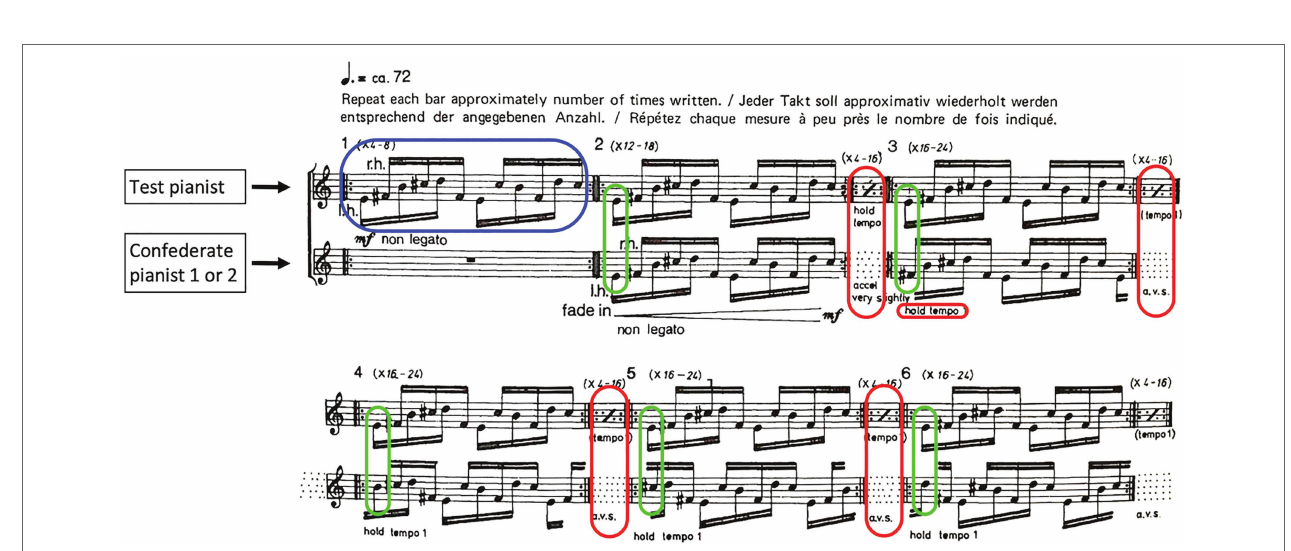
FIGURE 5 | Annotated first 11 bars of Piano Phase (1967) by Steve Reich (blue = melodic pattern, green = phase difference, and red = tempo instruction; reprinted with kind permission by Universal Edition AG, Vienna).